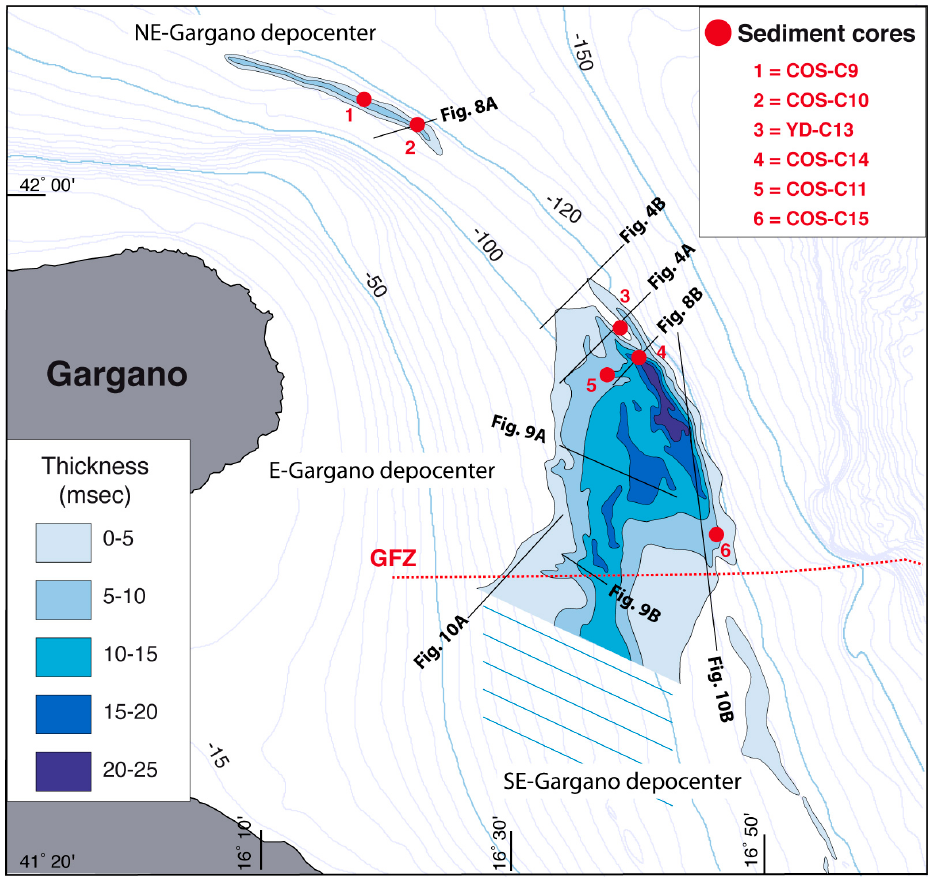
Figure 6. Isochronopachs of the early TST in the South Adriatic (1 msec ≅ 0.75 m in the investigated interval). Three separate depocenters are recognized NE, E and SE of Gargano Promontory, each comprising linear, contour-parallel deposits (between − 100 and − 120 m). The NE and SE depocenters are confined to the shelf edge, whereas the E-Gargano depocenter extends landward throughout a set of back-stepping deposits that progressively reduce their linear shape and ridged morphology. (Location of cores and seismic profiles is also reported; GFZ = Gondola Fault Zone; the oblique pattern indicates the area not covered by data used in this study).